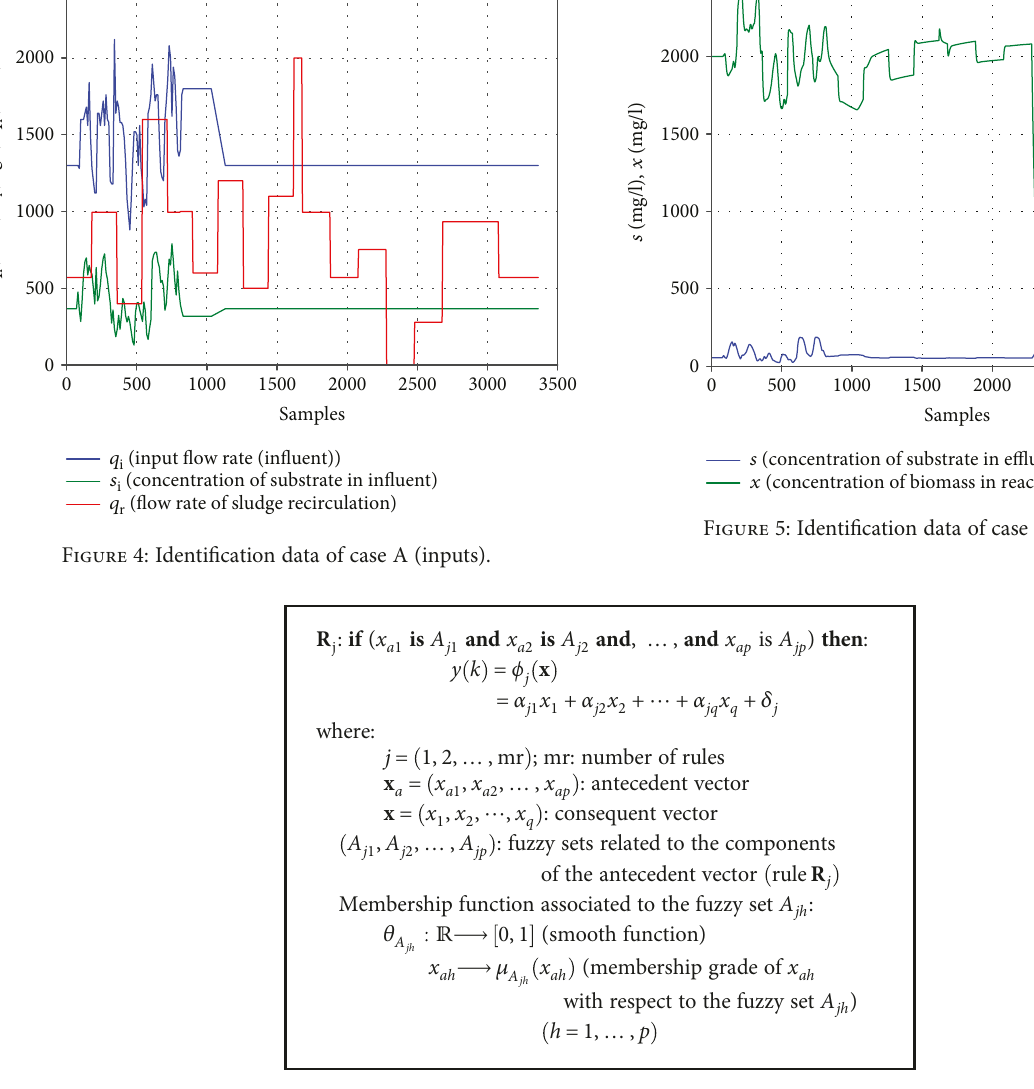
Algorithm 1: General form of the Takagi-Sugeno -type fuzzy